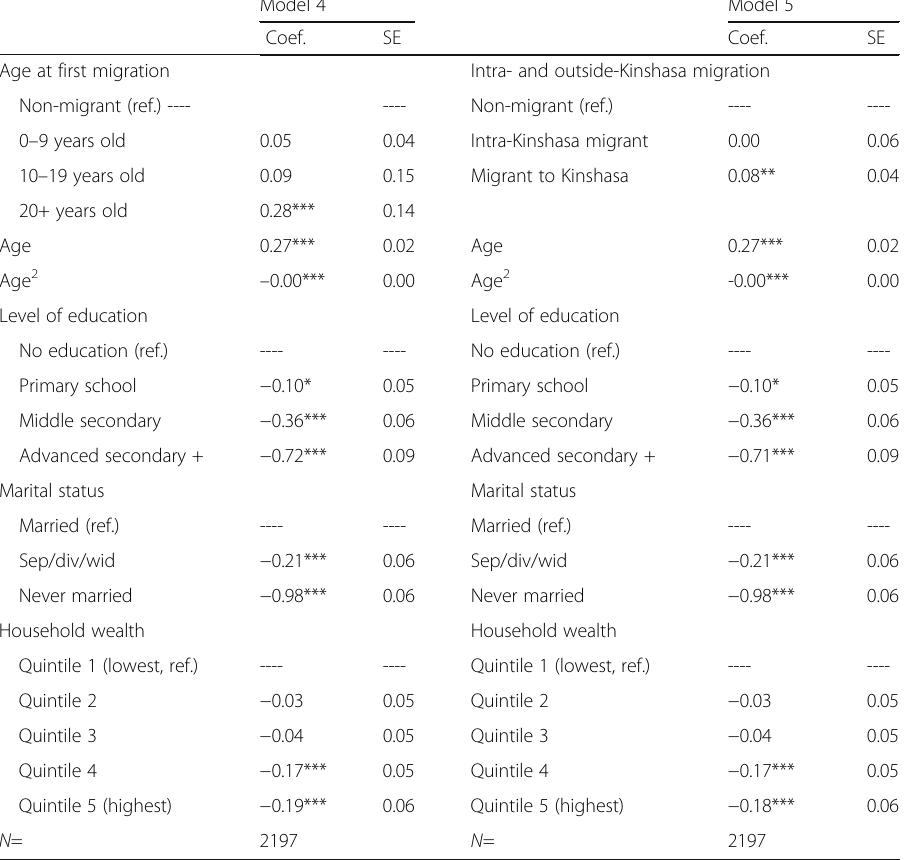
Table 7 Poisson regression results for the relationship between migration characteristics and fertility, PMA2020 Project, Kinshasa 2013